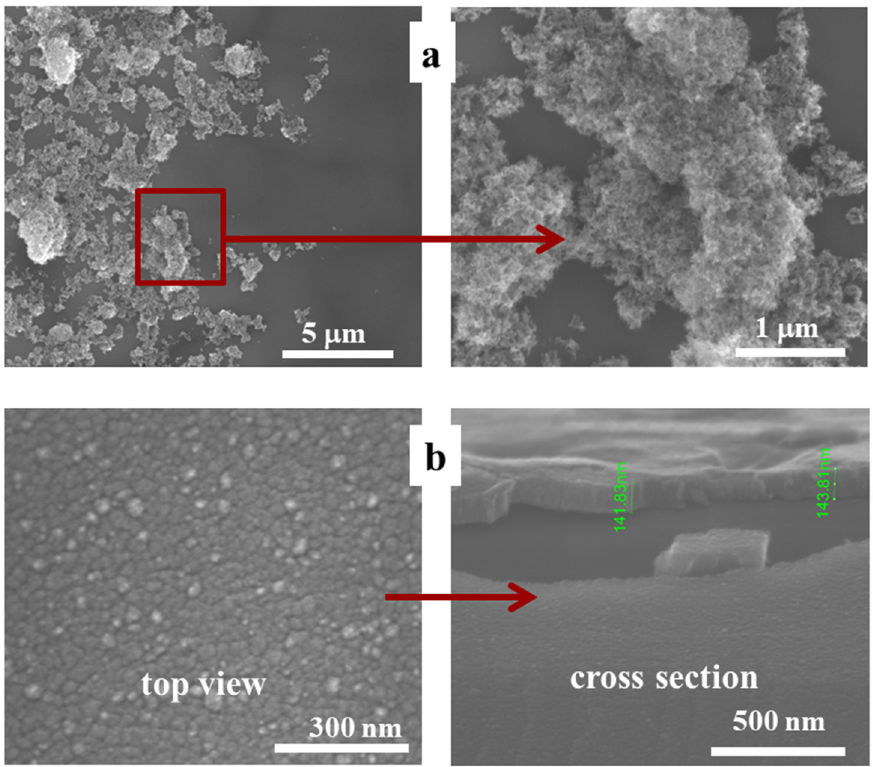
Figure 6. SEM images of thin films on Si substrate: ( a ) TiO 2 , and ( b ) a-SnO 2 .